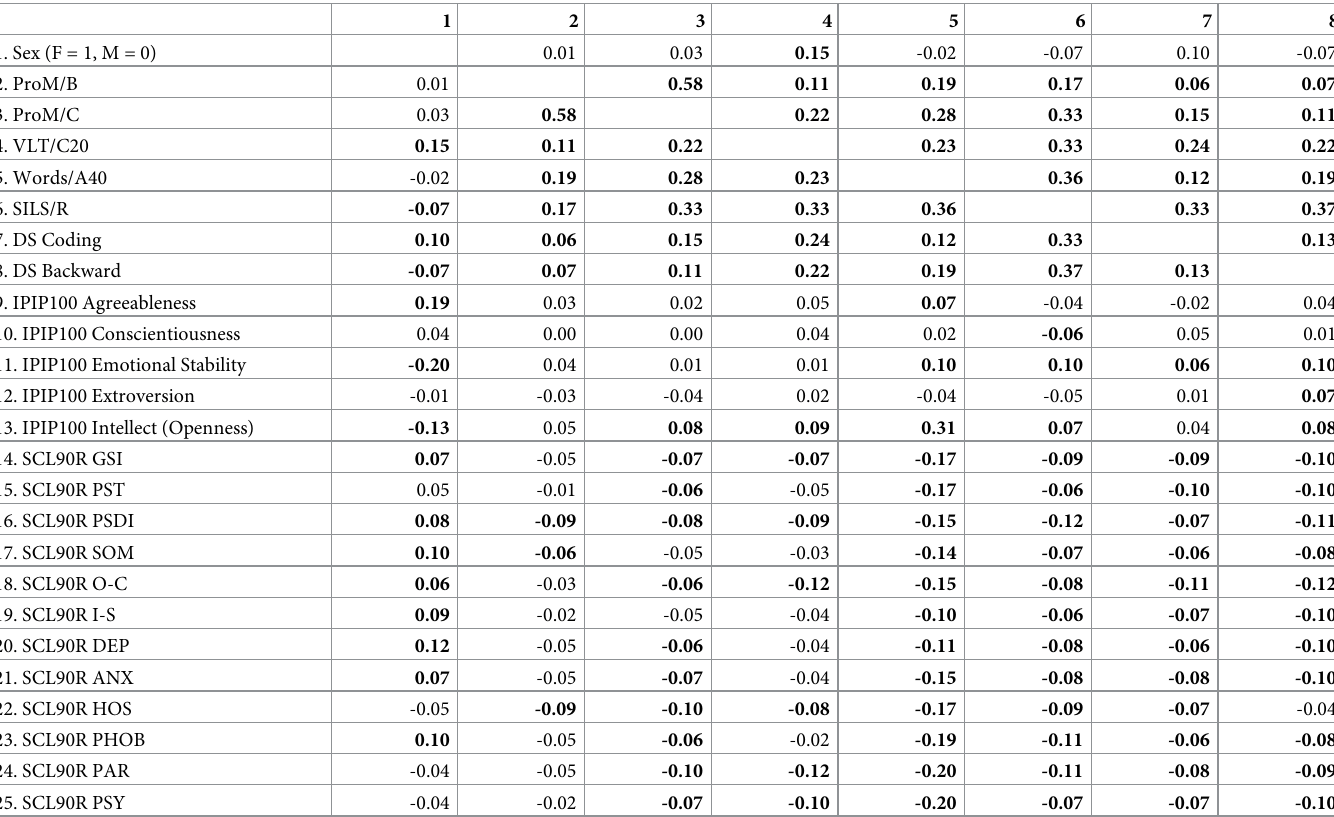
Table 3. Correlation matrix for all